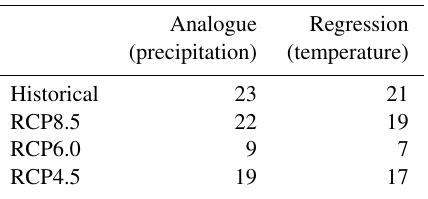
Table 3. Regionalized projections of temperature ( T max and T min ) and precipitation obtained by statistical methods (regression and analogue) based on AR5-IPCC